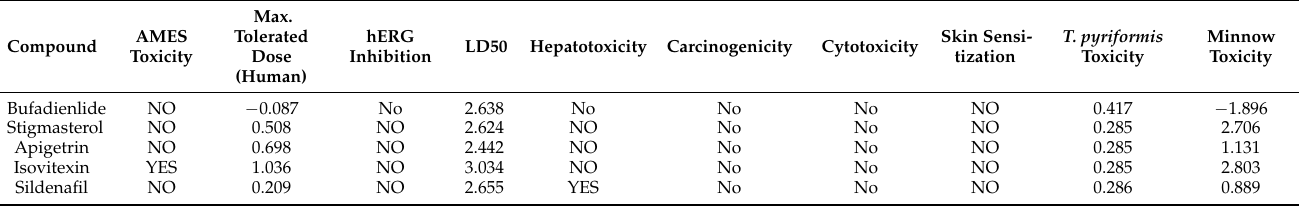
Table 4. List of the drug-induced hERG inhibition, AMES toxicity, carcinogens, Tetrahymena pyriformis (TP) toxicity, rat acute toxicity (LD 50 in mol kg − 1 ), and skin sensitization along with Minnow toxicity of selected top binding scored molecules.